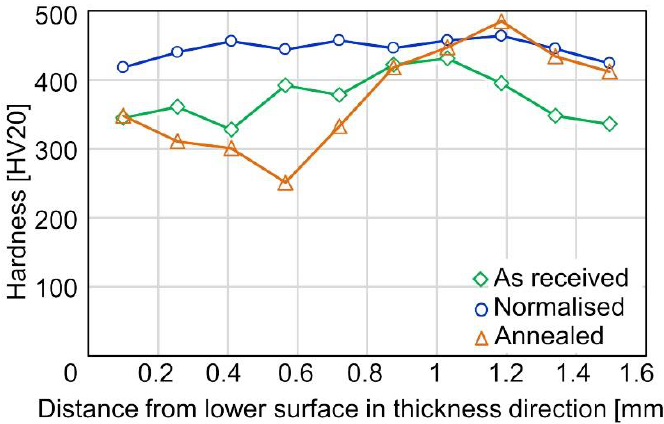
Figure 10. Effect of heat treatment of blank on distributions of Vickers hardness after die-quenching using direct resistance heating for v = 275 °C/s and t = 0 s.